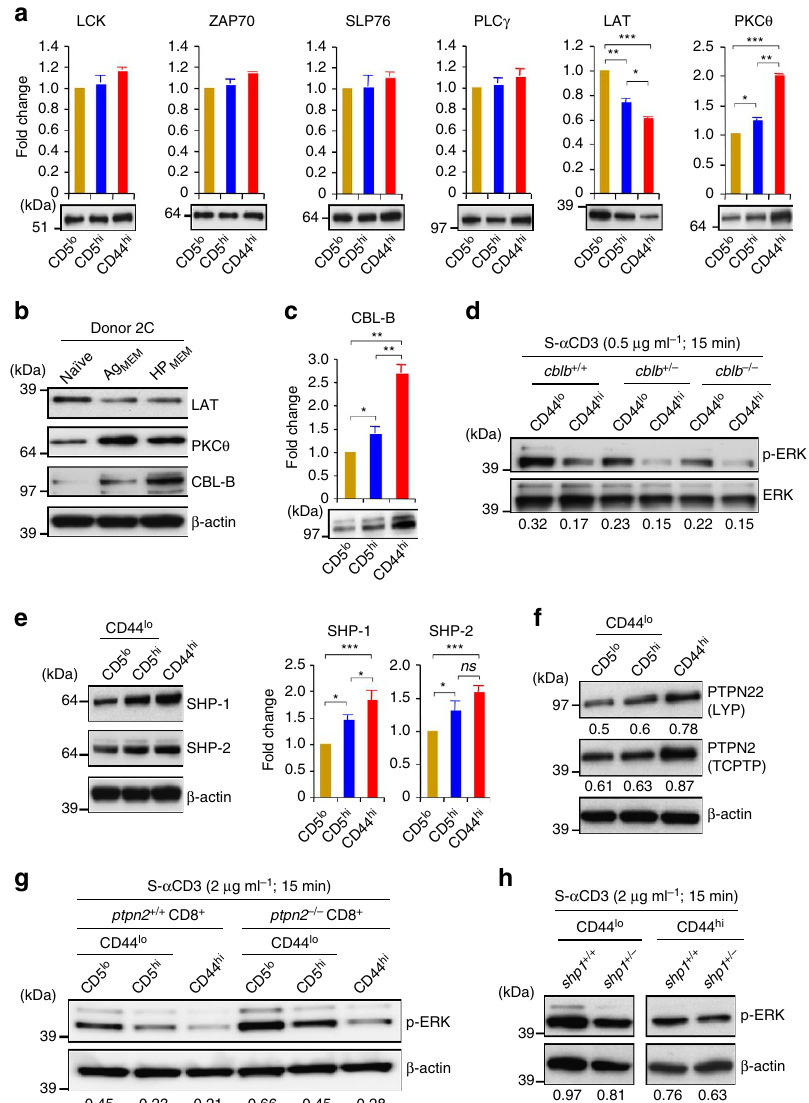
Figure 4 | Expression of TCR signalling proteins in CD8 þ Tcell subsets. ( a ) Expression levels of TCR signalling complex proteins, LCK, ZAP-70, SLP-76, PLC g , LATand PKC y in CD44 lo B6 naı¨ve CD5 lo and CD5 hi and CD44 hi MP CD8 þ Tcells, shown as fold change of densitometric levels (relative to b -actin; mean ± s.d.). ( b,c ) Expression levels of LAT, PKC y and CBL-B in 2C naı¨ve, Ag MEM and HP MEM CD8 þ Tcells as in Fig. 3a ( b ) and CBL-B levels in B6 CD44 lo CD5 lo and CD5 hi and CD44 hi CD8 þ T cells ( c ; mean ± s.d.). ( d ) ERK phosphorylation in CD44 lo and CD44 hi CD8 þ T cells from cblb þ / þ , cblb þ / (cid:2) or cblb (cid:2) / (cid:2) mice after incubation with S- a CD3 mAb. ( e ) Expression (Western blot and densitometry) of SHP-1 and SHP-2 in CD44 lo B6 naı¨ve CD5 lo and CD5 hi and CD44 hi MP CD8 þ T cells (mean ± s.d.). ( f ) Expression of PTPN22 (LYP) and PTPN2 (TCPTP) in CD44 lo B6 naı¨ve CD5 lo and CD5 hi and CD44 hi MP CD8 þ T cells. ( g ) ERK phosphorylation in CD44 lo naı¨ve CD5 lo and CD5 hi cells and CD44 hi MP CD8 þ T cells from ptpn2 þ / þ ( Ptpn2 fl/fl ) and ptpn2 (cid:2) / (cid:2) ( Lck-cre.Ptpn2 fl/fl ) mice after incubation with S- a CD3 mAb. ( h ) ERK phosphorylation in CD44 lo and CD44 hi CD8 þ Tcells from shp1 þ / þ and shp1 þ / (cid:2) mice (derived from SHP-1-deficient me v /me v mice) after incubation with S- a CD3 mAb. Data are representative of three ( a – e ) and two independent experiments ( f – g ). Unpaired Student’s t -test was used for the statistical analysis. * P o 0.05; ** P o 0.005; *** P o 0.0005; ns, not